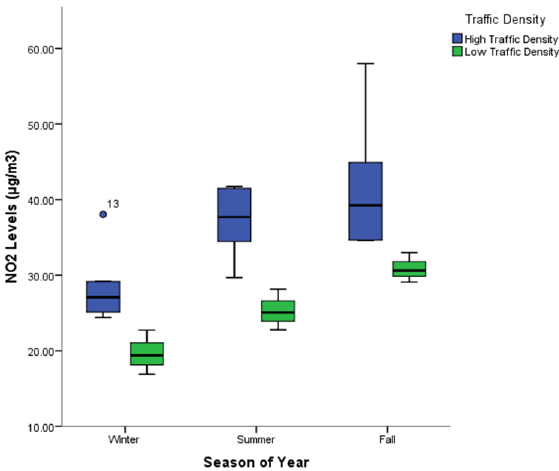
Figure 2. Variations in NO 2 concentrations (median) by traffic density across the three seasons.